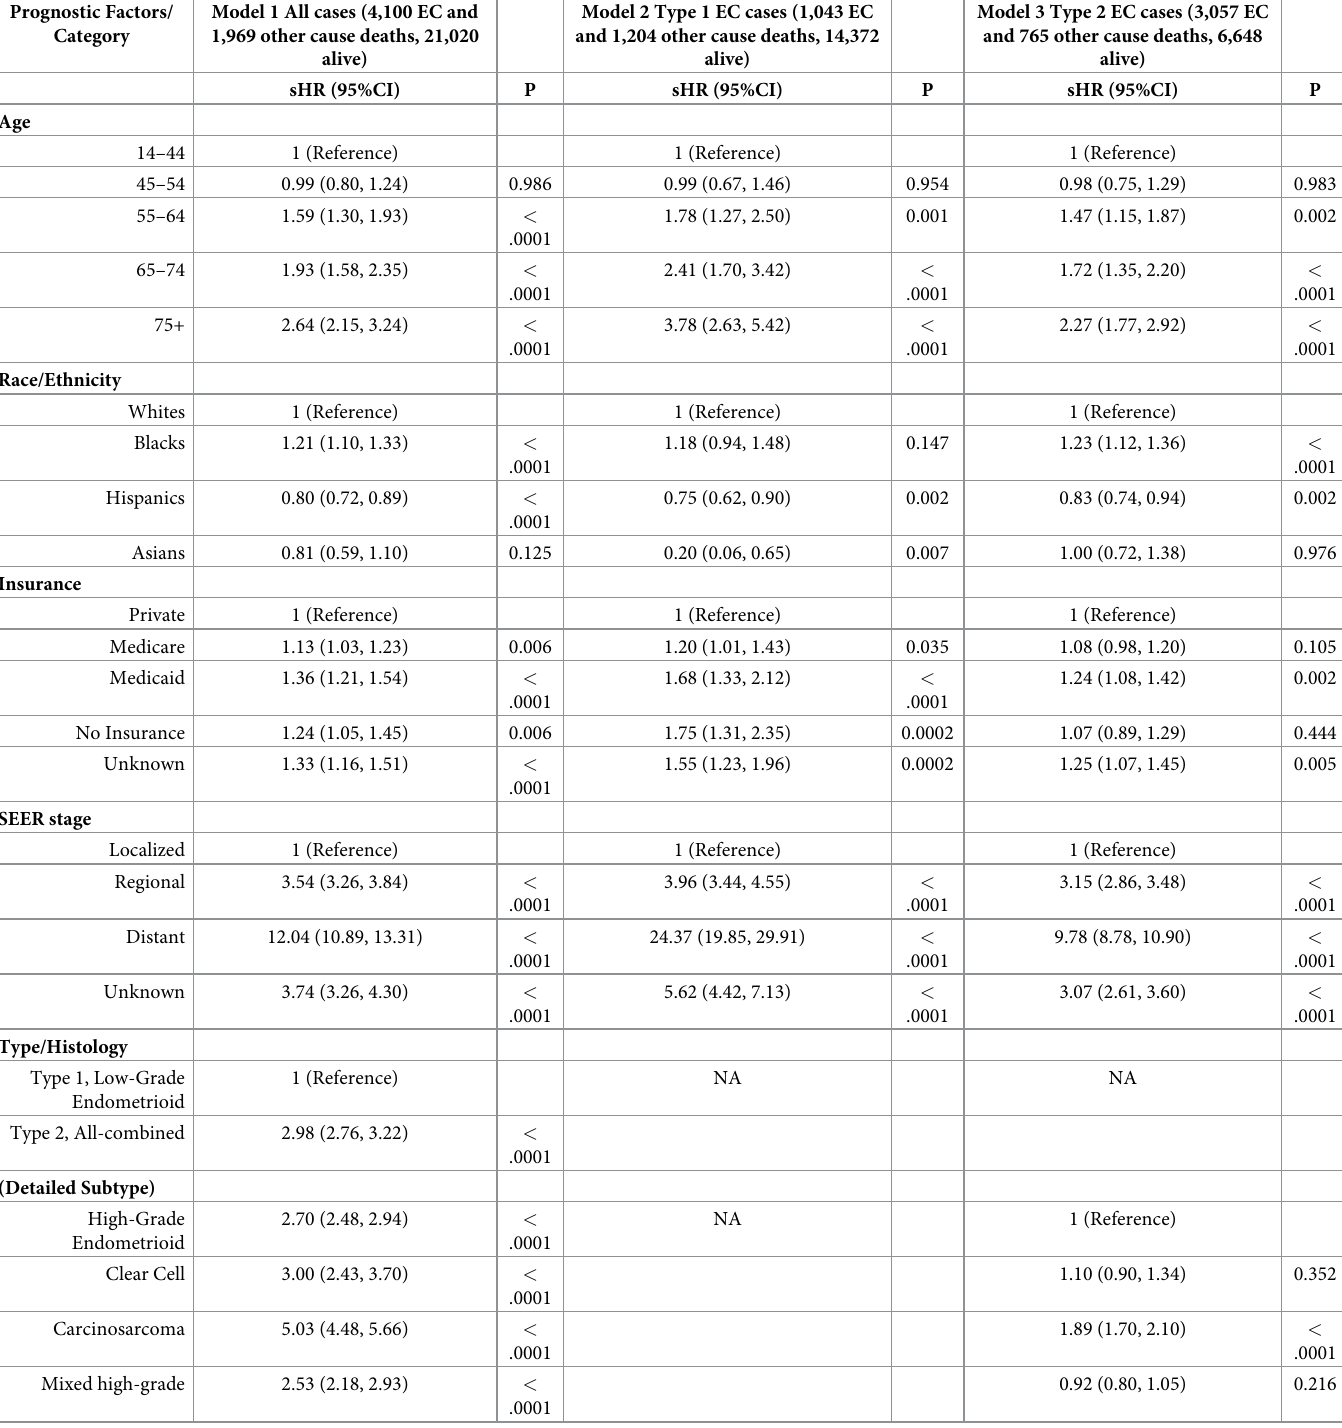
Table 5. Multivariable Fine-Gray regression models assessing demographic, social, and clinical predictors of risk of EC death in Florida, 2005–2016. Prognostic Factors/